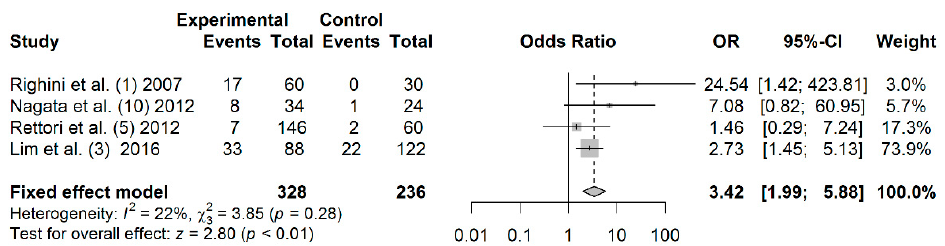
Figure 5. Forest plot for the association between TIMP3 promoter hypermethylation and HNC risk. The squares represent the ORs for individual studies. Bars represent the 95% CIs. The center of the diamond represents the summary effect size.